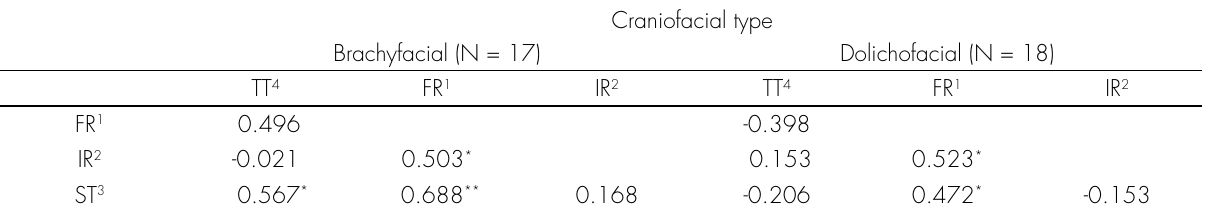
Table III. Correlations among surface roughness values and treatment times depending on the craniofacial type of the